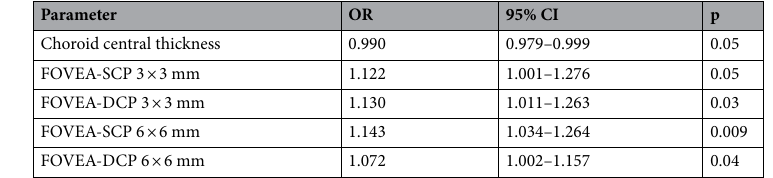
Table 3. OCT-A parameters significantly associated to the occurrence of intradialytic hypotension at logistic regression analyses. CRT central retinal thickness, FAZ foveal avascular zone, DCP deep capillary plexus, SCP superficial capillary